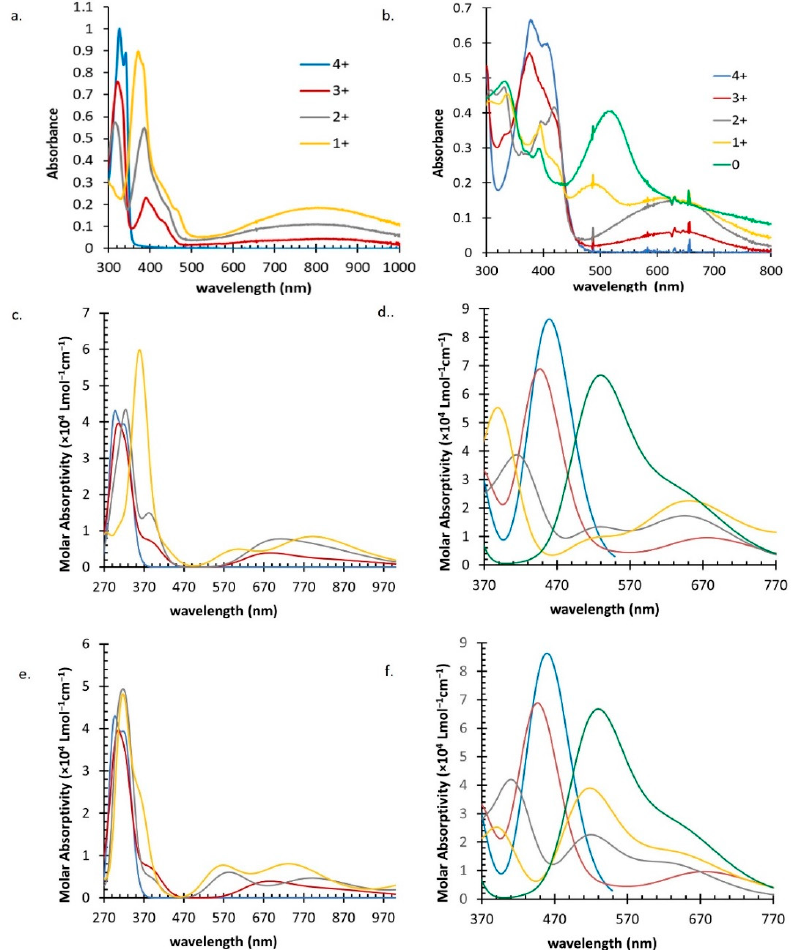
Figure 4. UV-vis spectra of individual charge states of ( a ) [Si(bpy) 3 ] n+ and ( b ) [Si(ttpy) 2 ] n+ . Simulated spectra of [Si(bpy) 3 ] n+ and [Si(ttpy) 2 ] n+ with ( c , d ) high-spin ground states and ( e , f ) low-spin ground states, respectively. The data shown in Figure 4a were previously reported in